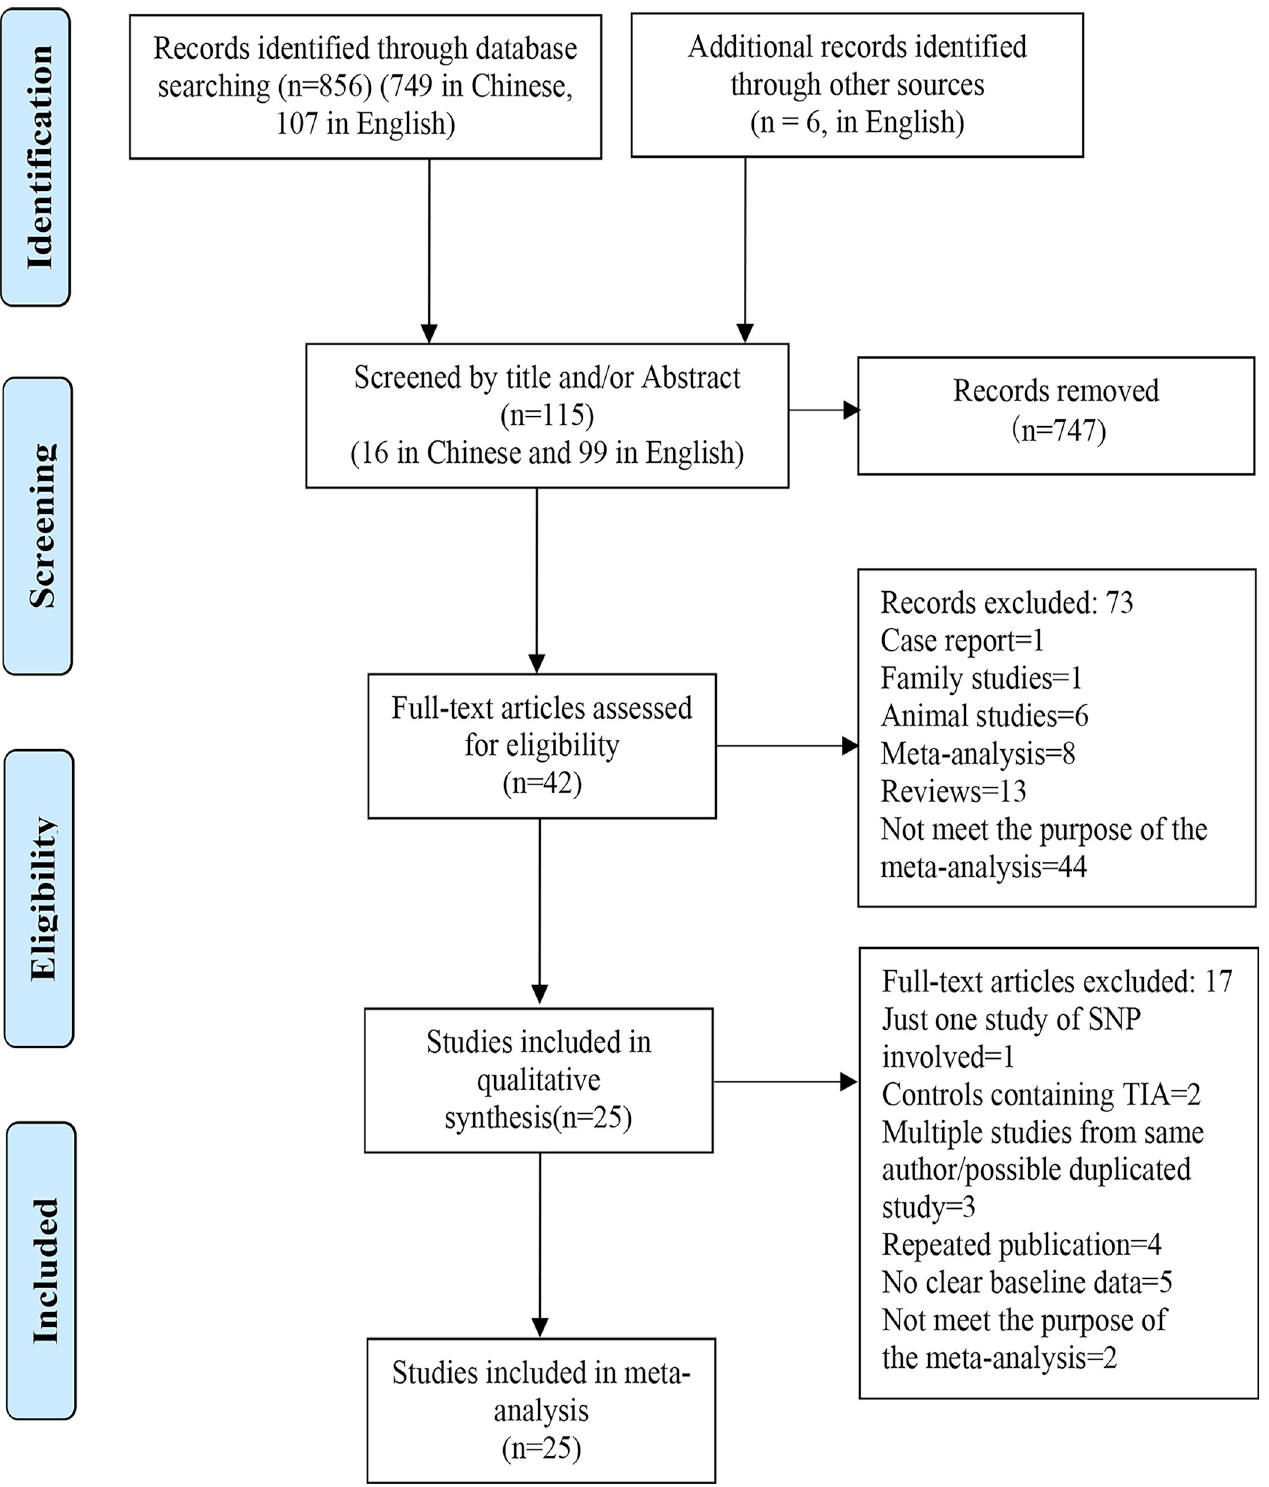
Fig 1. Flowchart of the literature search and article selection for the meta-analysis.